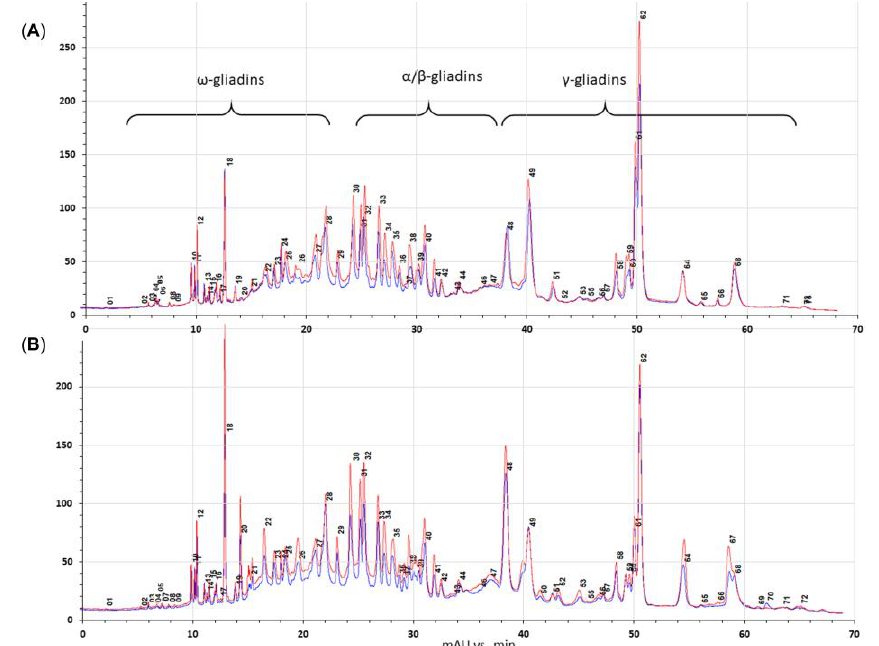
Figure 6. Comparison of reverse-phase high-performance liquid chromatography (RP-HPLC) chro- matograms of gliadin factions from wasko.gl − (( A ), upper traces) and wasko.gl+ (( B ), lower traces) wheat genotypes, with different N treatments (blue - N0 and red - N120).